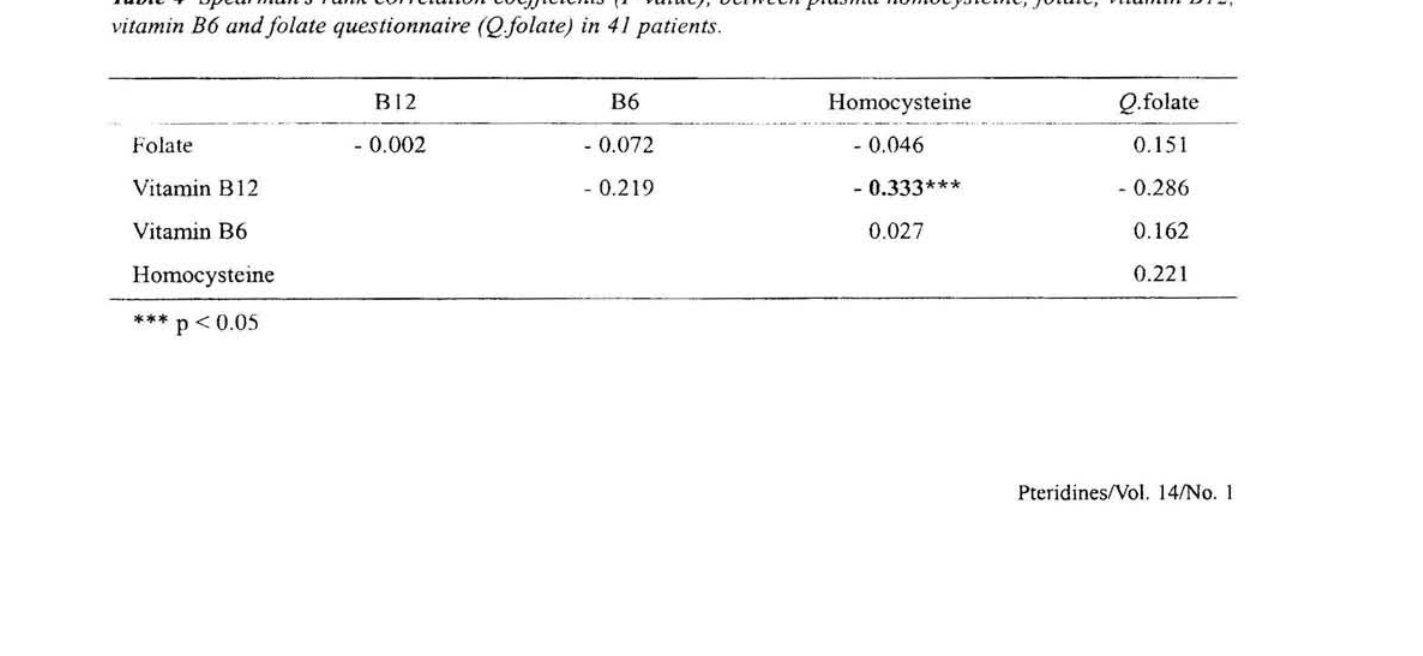
Table 4 Spearman's rank correlation coefficients (P value), between plasma homocysteine, folate, vitamin Bl2, Vitamin B6 and folate